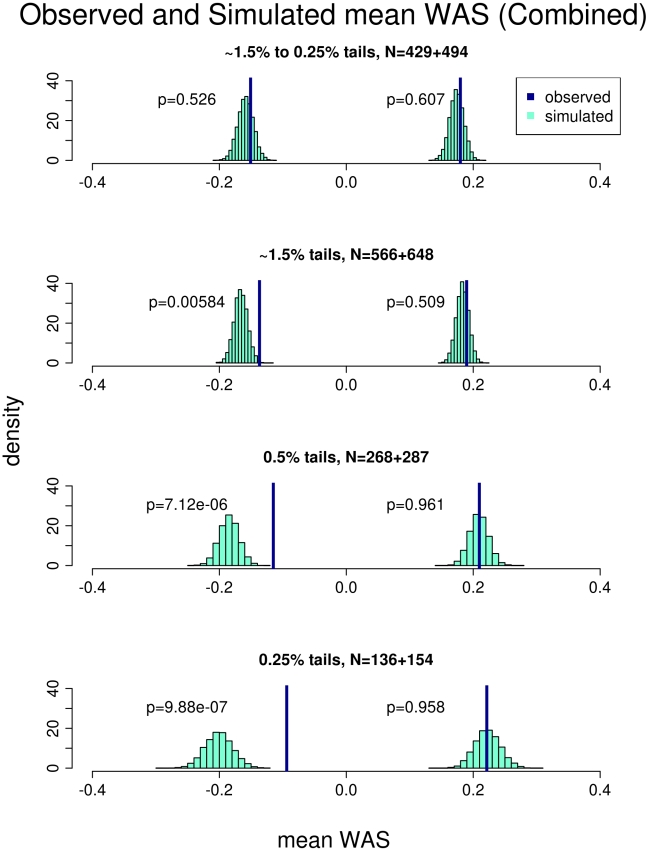
Comparison of the observed versus simulated mean weighted allele score (WAS) in the combined cohort.The plot shows the result of comparing the mean WAS of the short and tall individuals observed from both the HUNT and FINRISK cohorts against that obtained from simulation. Each row represents a different stratification of the extremes. The percentiles and number of individuals in the short and tall extreme respectively are listed for each stratum. The p-values represent the comparison between the observed and simulated mean WAS. The observed mean WAS for the tall individuals are not different from the simulation in any of the strata. The observed mean WAS for the short individuals is not different from the simulation in the first stratum. As a progressively more extreme sample is used, the short individuals' mean WAS becomes progressively more significantly different than the simulation.